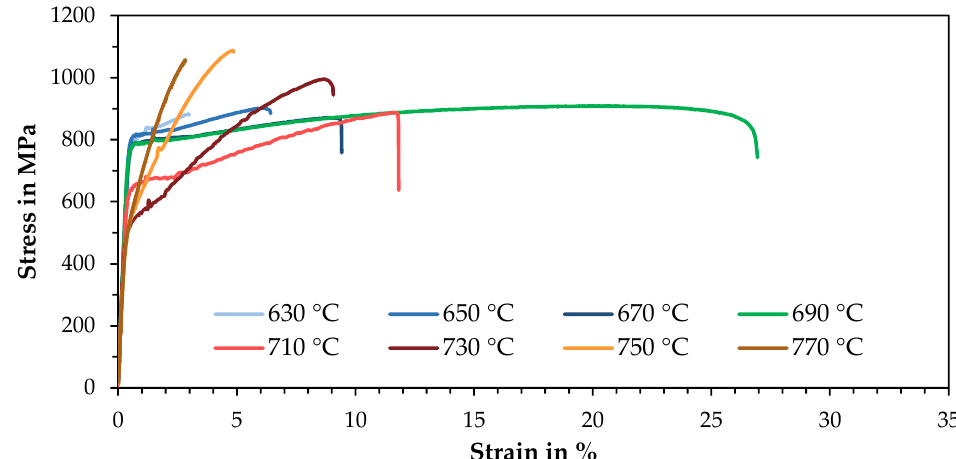
Figure 3. A stress-strain diagram of LPBF specimens after an intercritical annealing process of 10 min at different temperatures.